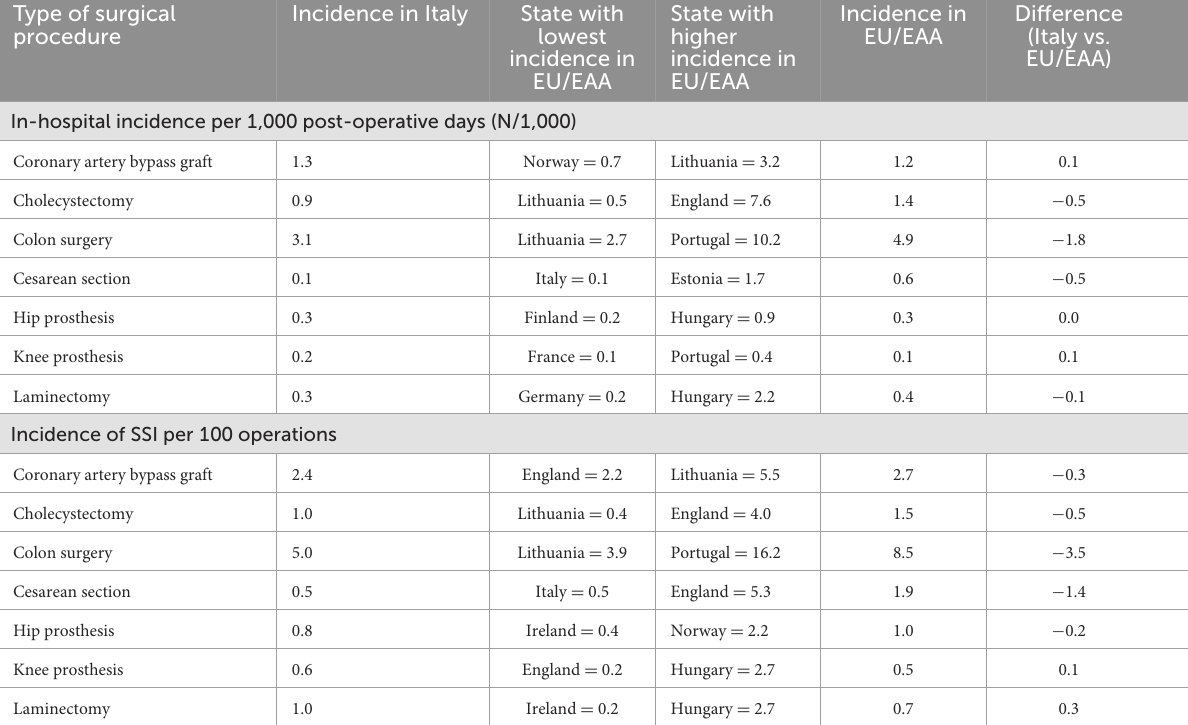
TABLE 4 Incidence of surgical site infections per major types of surgical procedures in Italy and European